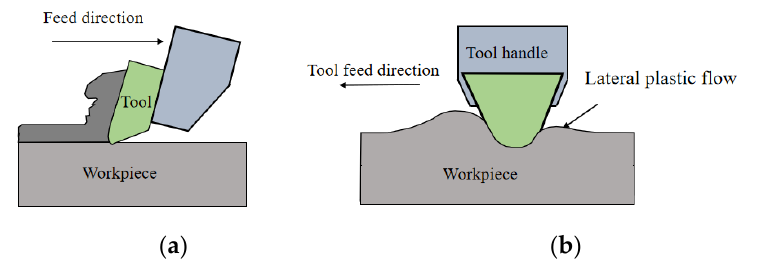
Figure 5. Schematic diagram of lateral plastic flow in metal machining process [30]. ( a ) Cutting direction, ( b ) tool feed direction.